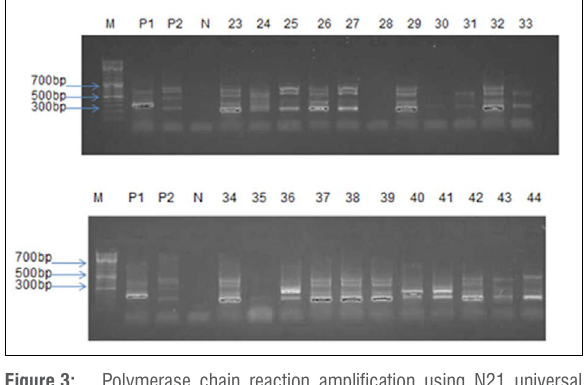
Figure 3: Polymerase chain reaction amplification using N21 universal primer for identification of pure yeast cultures.